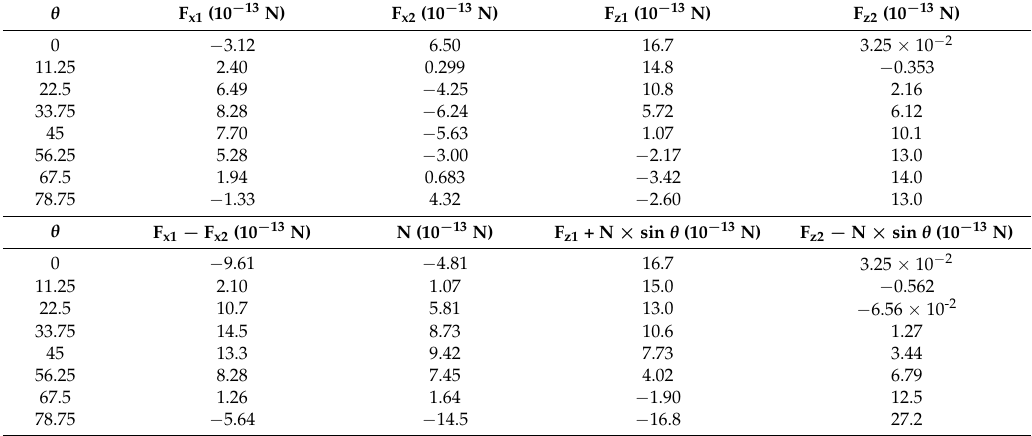
Table 2. Forces on two particles (particle 2 sits atop the electrode 20 µ m from the left edge on the